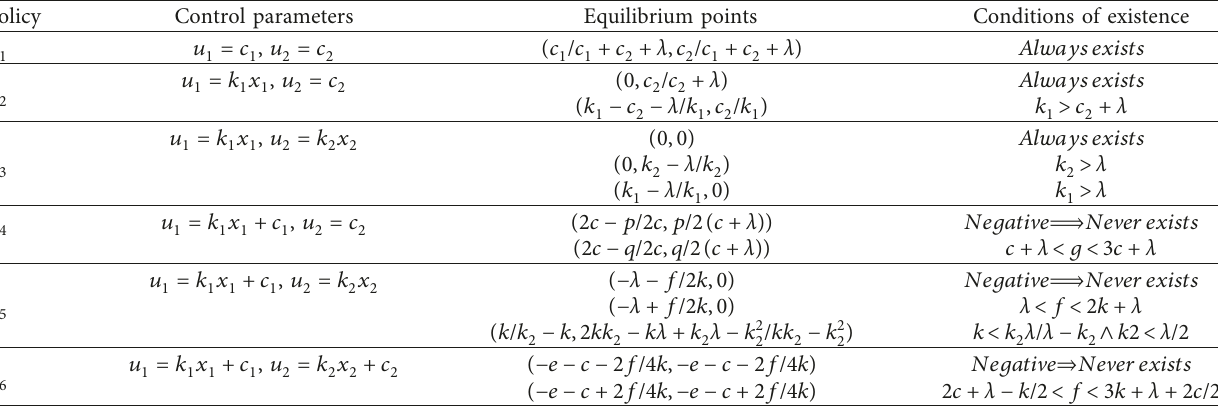
Table 6: Equilibrium points and conditions of the advertising policy parameters for existence of the equilibrium points under special cases of affine policy, for both the Vidale–Wolfe and extended Lanchester models (cf. Theorem 1).